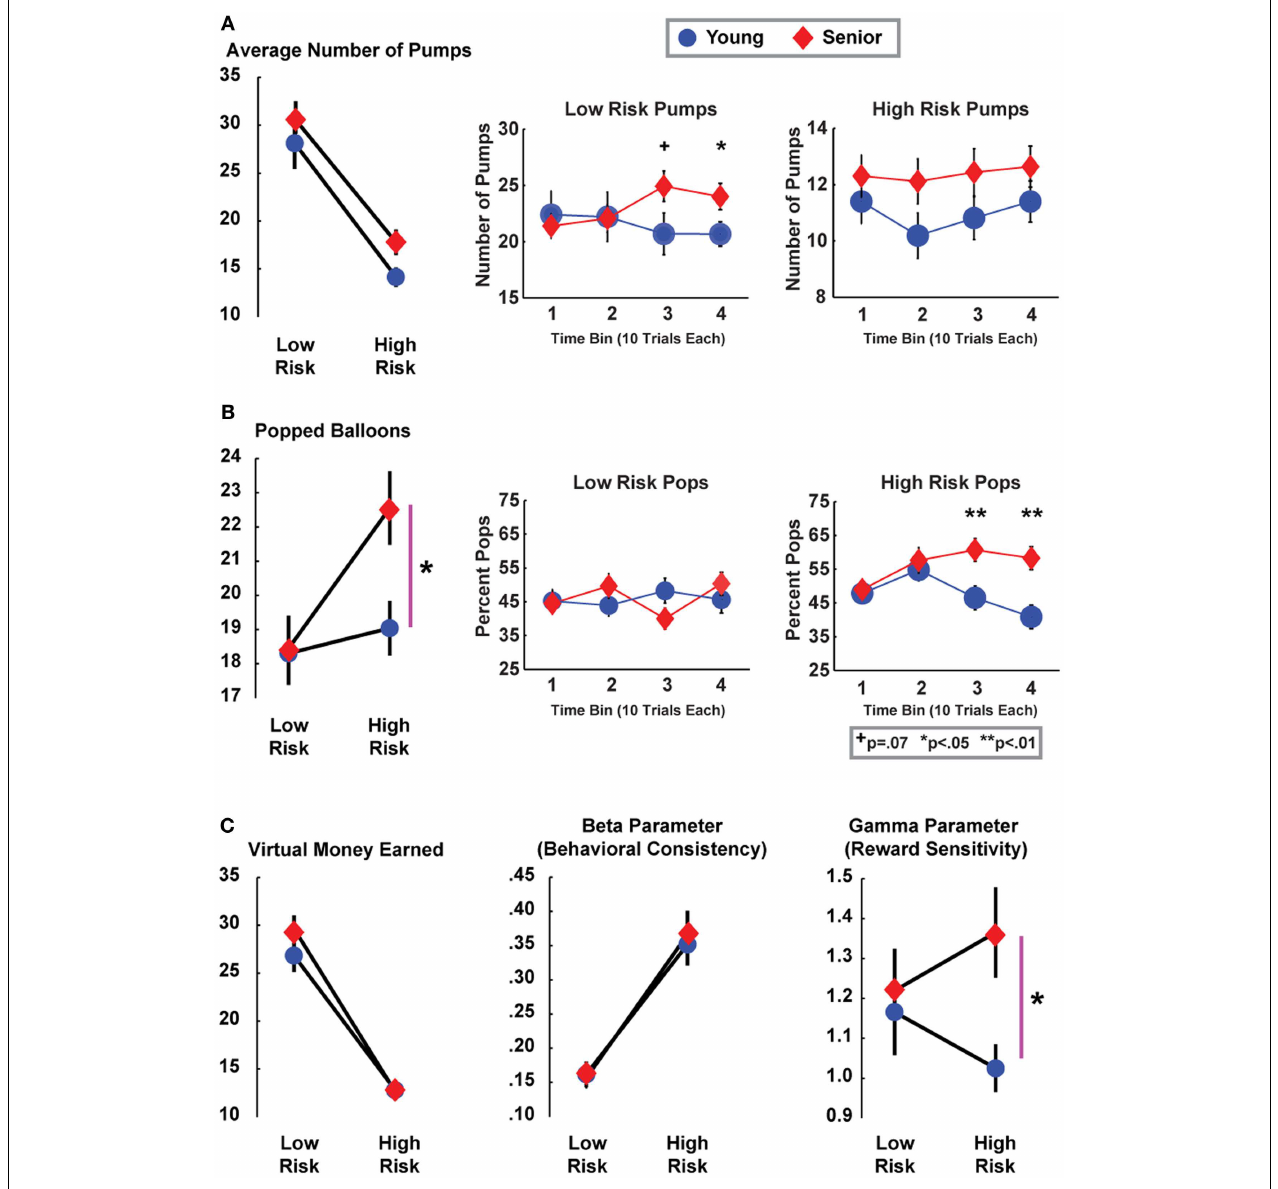
condition, particularly later in the block. (C) The decision quality underlying these patterns is difficult to interpret, since groups did not differ in the amount of virtual earnings. However, cognitive modeling revealed that these performance differences were associated with a heightened reward sensitivity parameter in seniors in the high risk